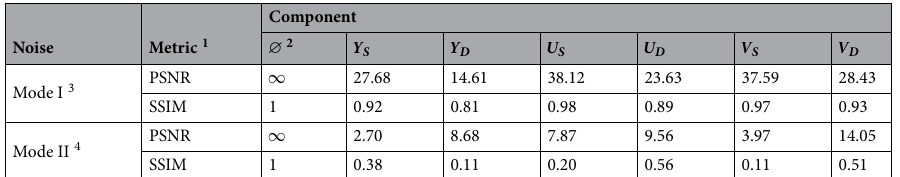
Table 7. The quality of the reconstructed image when salt and pepper noise is added to a component. The 1 experimental results are obtained on the DRIVE dataset. The difference evaluation between the reconstructed 3 2 image and the original image. It means no loss of components. Parameters: a =0, b =15, P a =0.05, P b =0. Parameters: a =0, b =15, P a =0, P b =0.05.